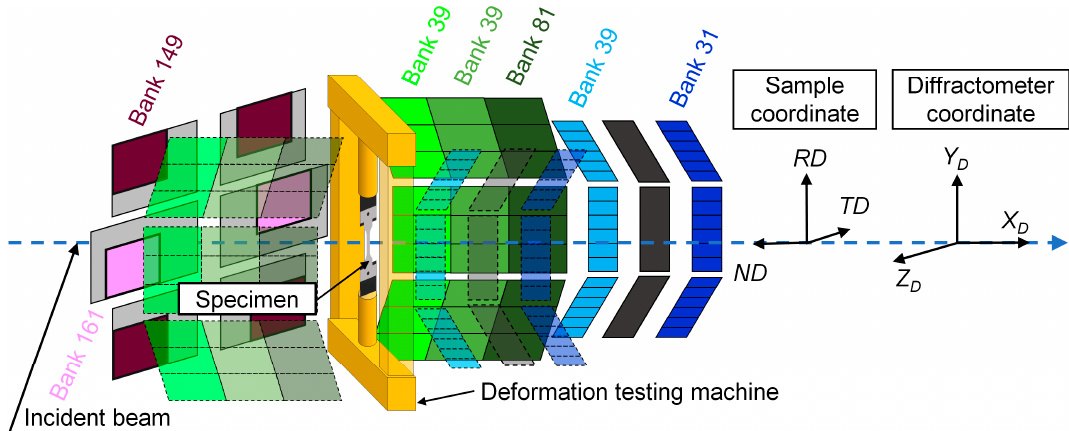
Figure 2. Schematic of iMATERIA equipped with the deformation-testing machine.